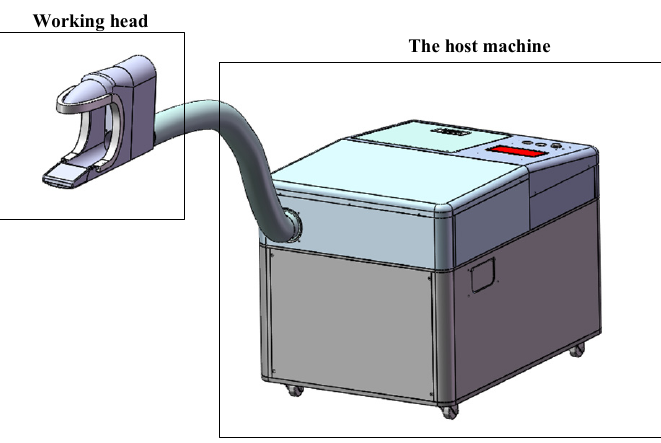
Figure 2. Mechanical structure of nursing equipment.